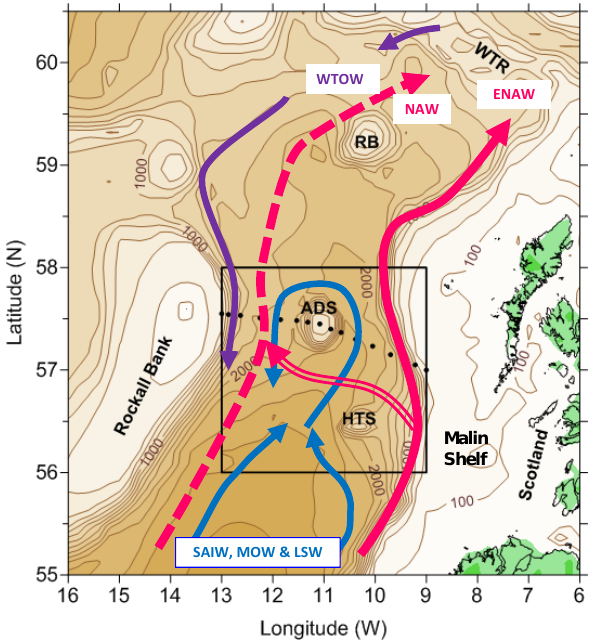
Figure 1. Map of the Rockall Trough with bathymetry (m) and the major currents. WTR: Wyville Thomson Ridge; RB: Rosemary Bank; HTS: Hebrides Terrace Seamount. Other acronyms are de- fined in the text. D340 stations are shown as a series of black dots. The red “tramway” is the alternative route of ENAW identified in this paper. The black box outlines the area that EKE is averaged over in Fig. 9.